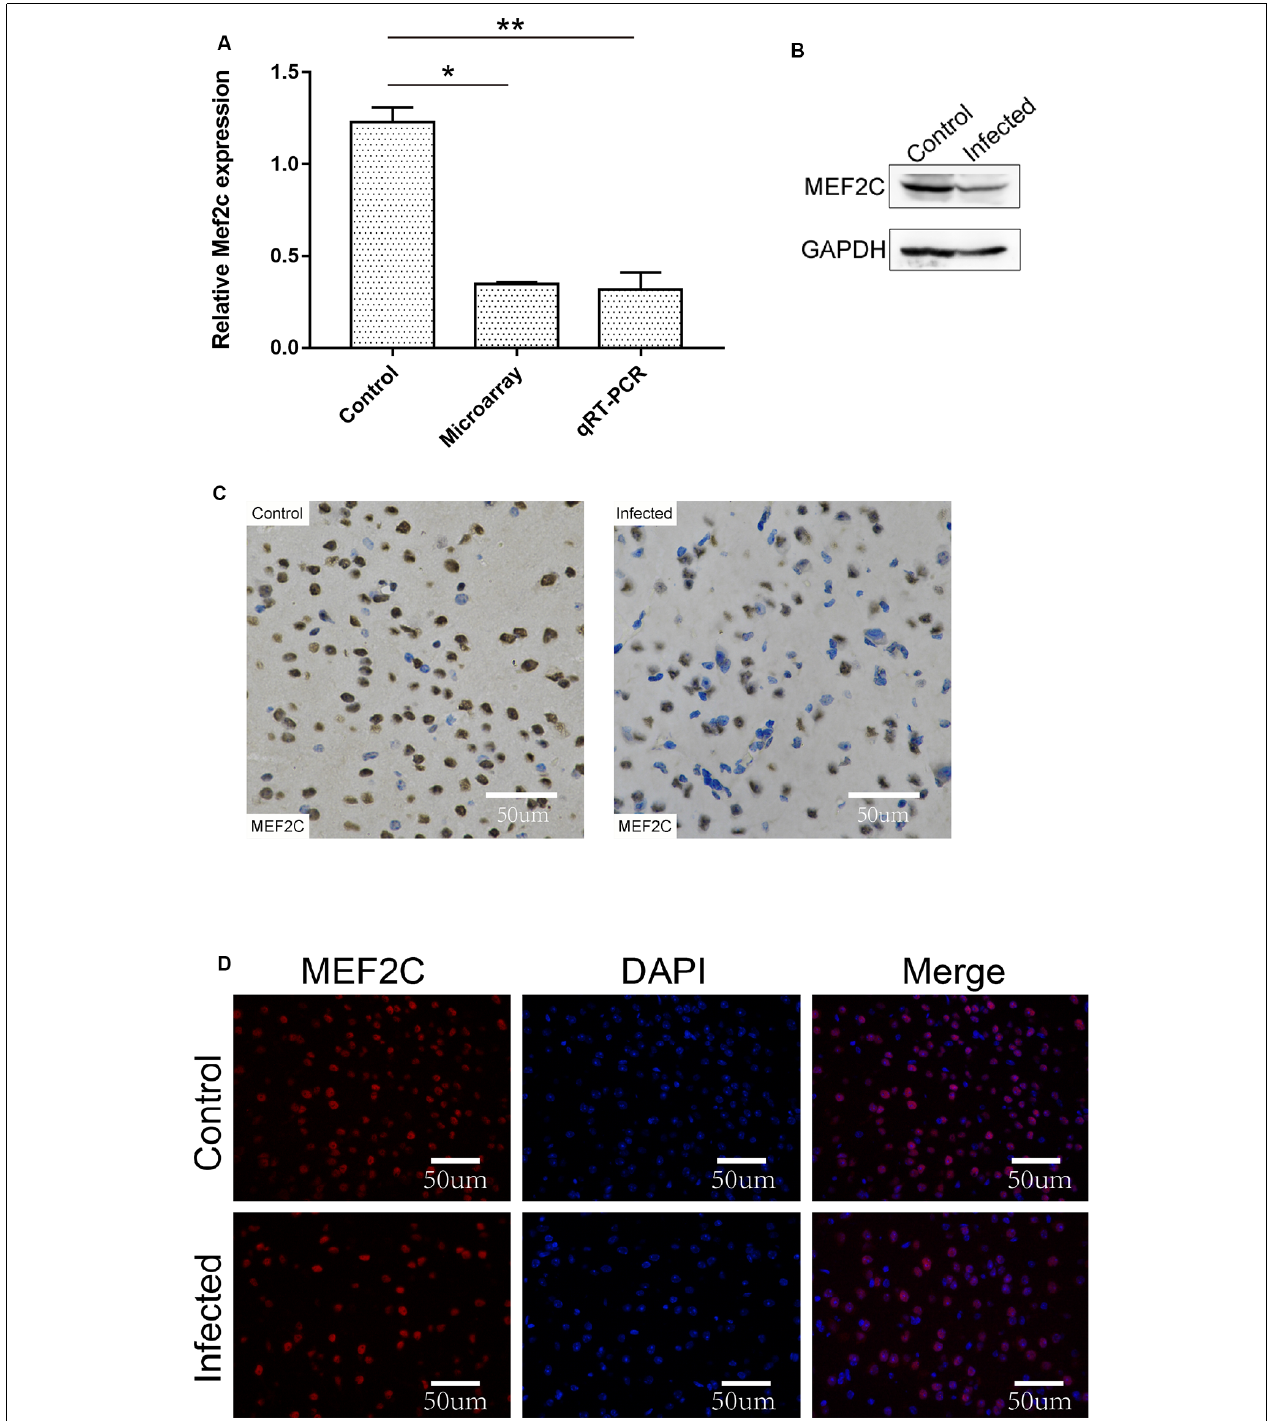
FIGURE 4 | Validation of the expression of Mef2c in the brain of mice infected with T. gondii . (A) The expression of Mef2c in the brain of mice infected with T. gondii was tested by qRT-PCR. All values are presented as mean ± SD for three independent experiments (* P < 0.05, ** P < 0.01, student’s t -test). (B) The expression of MEF2C protein in T. gondii infected and uninfected mouse brain was analyzed by Western blot. (C) Immunohistochemical analysis of MEF2C protein in T. gondii infected and uninfected mouse brain. The slice derived from brain was subsequently subjected to rabbit anti-MEF2C antibody and HRP Goat Anti-Rabbit IgG, and then nucleus stained with hematoxylin staining solution. MEF2C protein shows in yellow color. (D) Immunofluorescence analysis of MEF2C protein expression in T. gondii infected and uninfected mouse brain. The slice derived from brain was subjected to immunofluorescence with the primary antibody against MEF2C (red). DAPI (blue) was used for